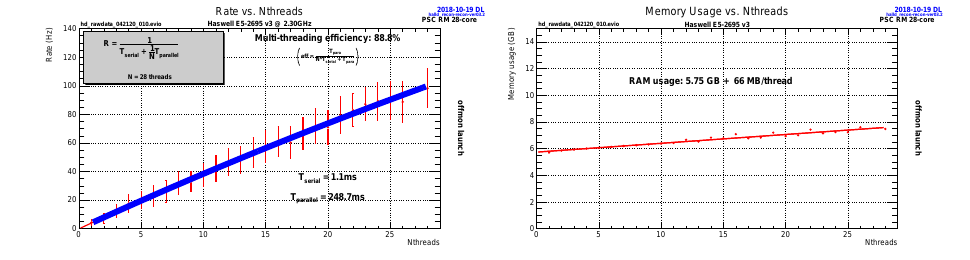
Figure 6. (Top)Thread scaling for PSC Bridges RM node. (Bottom)Memory usage vs. number of threads for GlueX reconstruction job on PSC Bridges RM